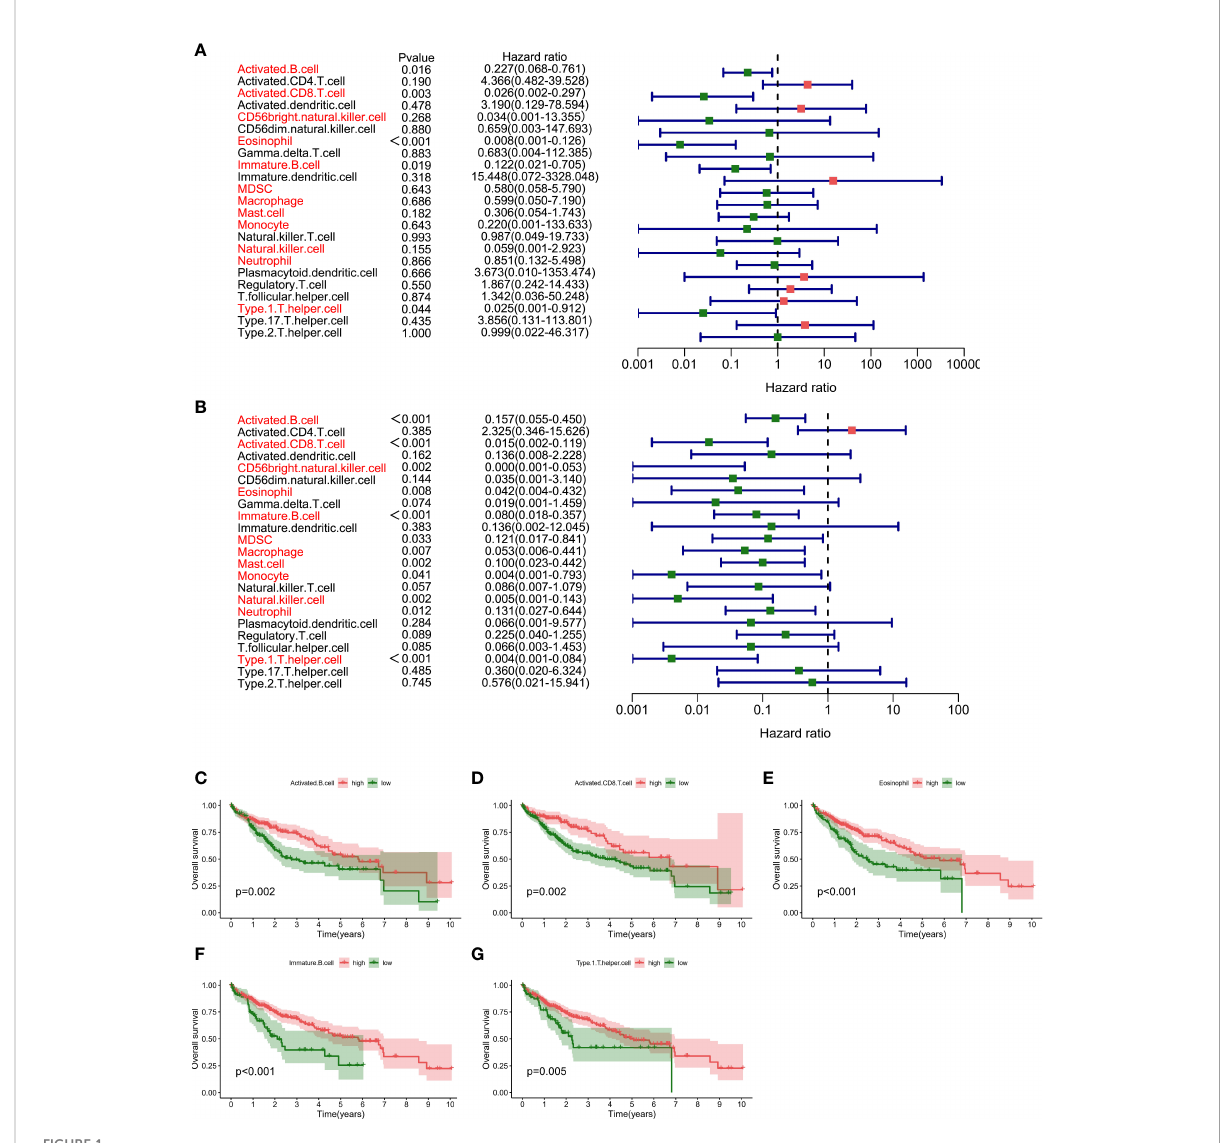
FIGURE 1 Prognostic value of immune cell in fi ltration in HCC (A) . Survival analysis by Cox regression analysis illustrated the correlation of 23 immuno- cells with overall survival condition (B) . Survival analysis using the Cox regression analysis method shows the association of 23 immune cells with progression-free interval (PFI) (C – G) . Kaplan-Meier survival analyzation and log-ranking test are performed for the veri fi cation regarding the correlation of speci fi c immune cells in